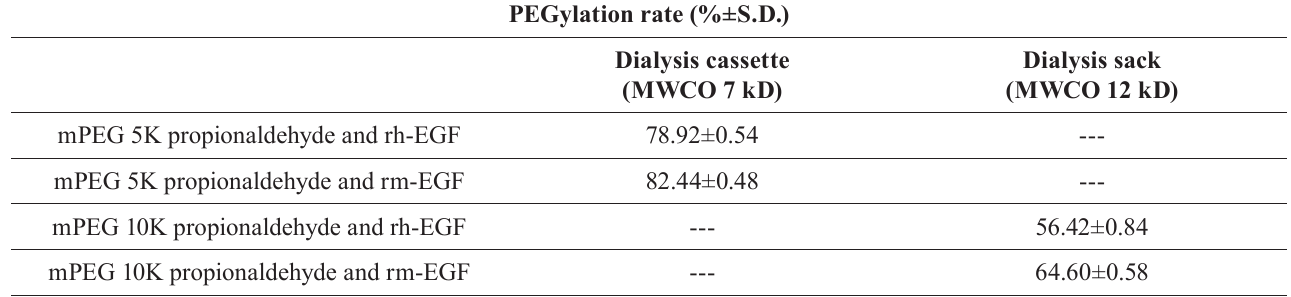
TABLE II - PEGylation rate of different samples. Dialysis cassette (MWCO 7 kD) was used for samples including mPEG 5K propionaldehyde, rh-EGF, and rm-EGF. Dialysis membrane (MWCO 12 kD) was used for samples including mPEG 10K propionaldehyde, rh-EGF, and rm-EGF